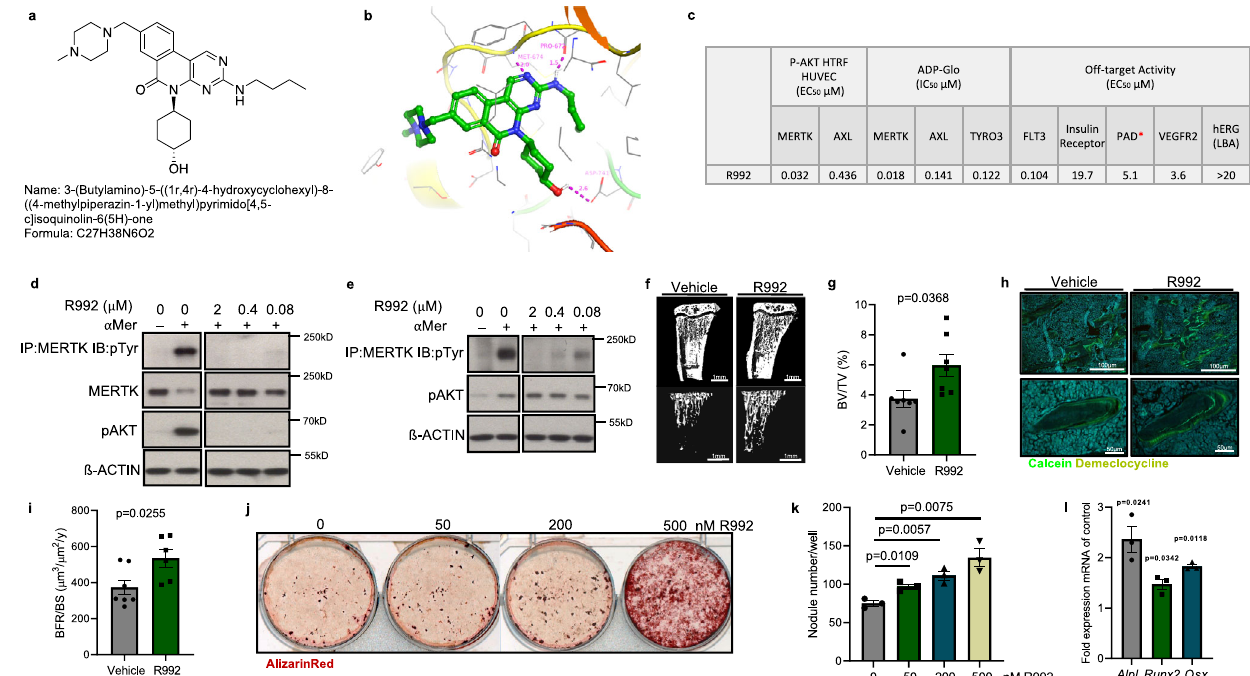
Fig. 4 | The MERTK-inhibitor R992 induces bone formation in healthy mice. a Structure and chemical formula of R992: 3-(Butylamino) − 5-((1r,4r) − 4-hydro- xycyclohexyl) − 8-((4-methylpiperazin-1-yl)methyl)pyrimido[4,5-c]isoquinolin- 6(5H)-one(C27H38N6O2). b IllustrationofR992dockedinMERTKandtheH-bonds R992 forms with three residues in the ATP pocket (MET-647, PRO-672, and ASP- 741). c R992 on-target and off-target activity. d , e Immunoblots of MERTK phos- phorylation and AKT signaling in human ( d ) and murine ( e ) cells. f μ CT of the metaphyseal proximal region of tibias of 10-week-old healthy C57BL/6J mice trea- ted after 2 weeks of treatment with vehicle or R992. g Quanti fi cation of trabecular bone volume (BV/TV) of the proximal tibia determined by μ CT analysis (Vehicle